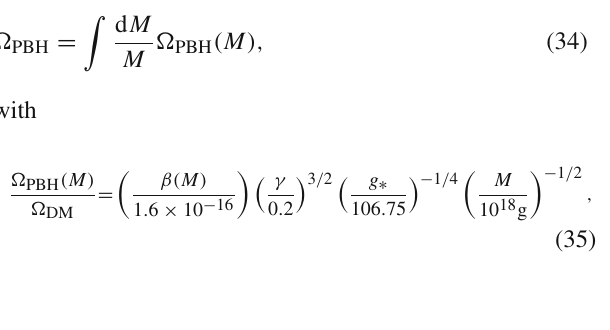
masses M one can get the present abundance of PBHs,